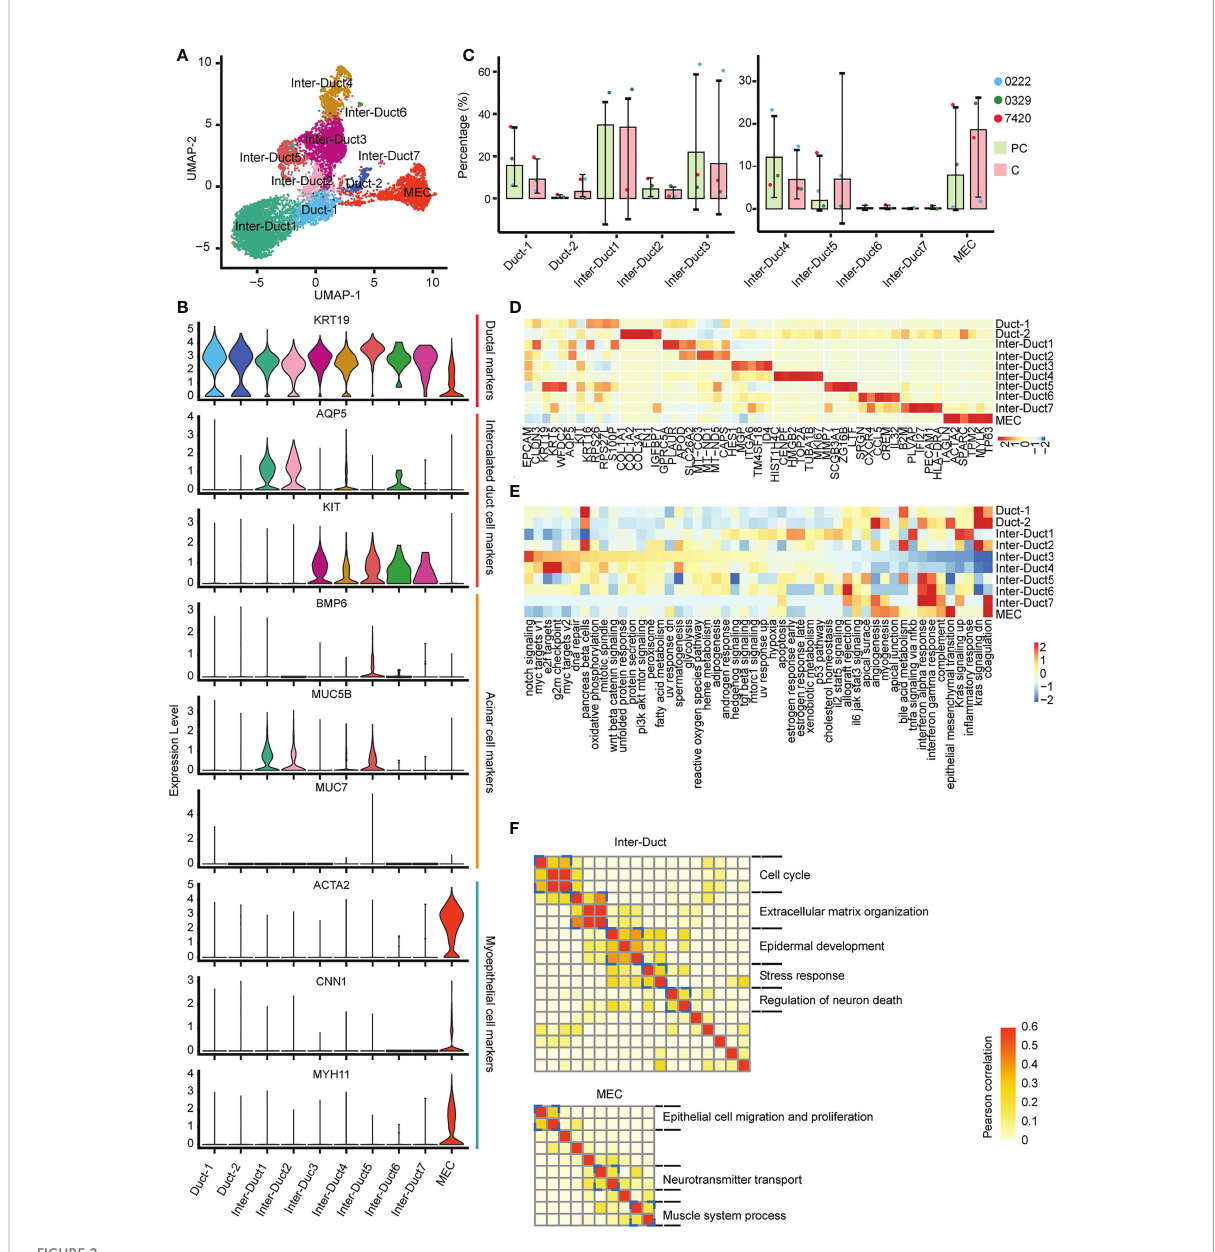
FIGURE 2 Different epithelial cell subtypes with speci fi c functions. (A) UMAP visualization of 10 epithelial cell subtypes across the three patients. (B) Violin plots showing the expression of duct, acinar, and myoepithelial cells markers in epithelial cells subtypes. (C) The relative abundance of 10 epithelial cell subtypes in the paracarcinoma (PC) and carcinoma (C) tissues. (D) Heatmap of differentially expressed genes in epithelial cell clusters. (E) Heatmap showing differences in 50 hallmark pathways enrichment scores among each epithelial cell subtype. (F) Heatmap showing pairwise correlations of intratumoral programs derived from Inter-Duct (top) and myoepithelial-like cells (bottom). Coherent expression programs across tumors are marked on the